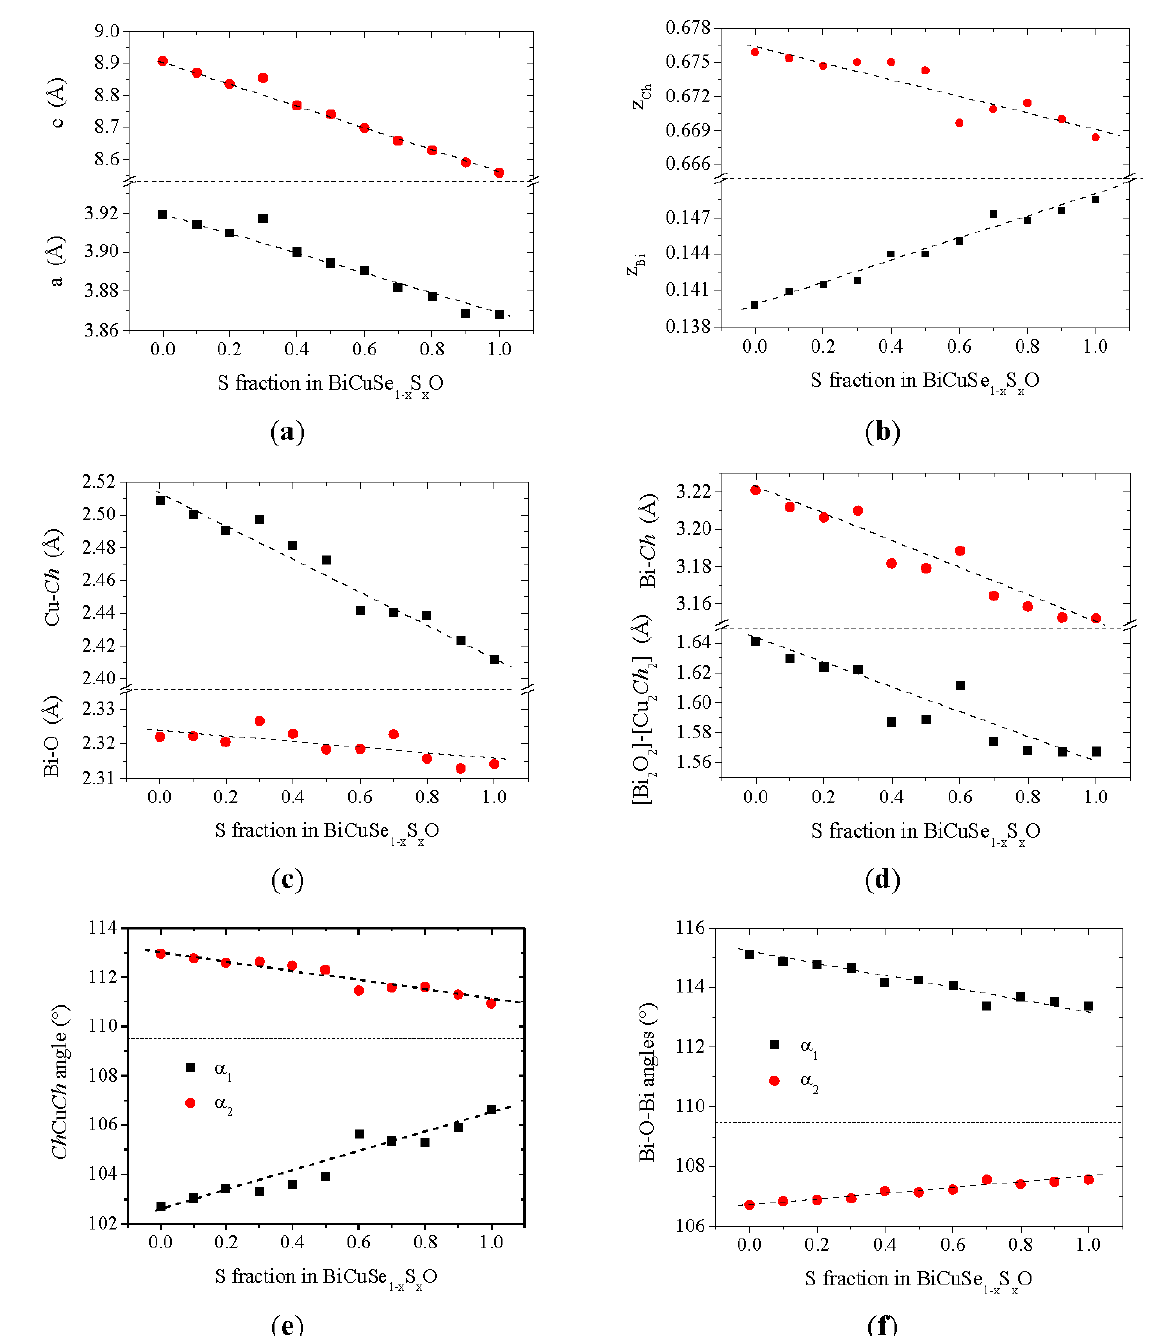
Figure 3. Structural parameters of the BiCuSe 1−x S x O samples: lattice parameters ( a ); Bi and Ch atomic positions ( b ); Bi-O and Cu- Ch distances ( c ); Bi- Ch distance and distance between [Bi 2 O 2 ]-[Cu 2 Ch 2 ] planes ( d ); Cu Ch 4 tetrahedra angles ( e ) and OBi 4 tetrahedra angles ( f